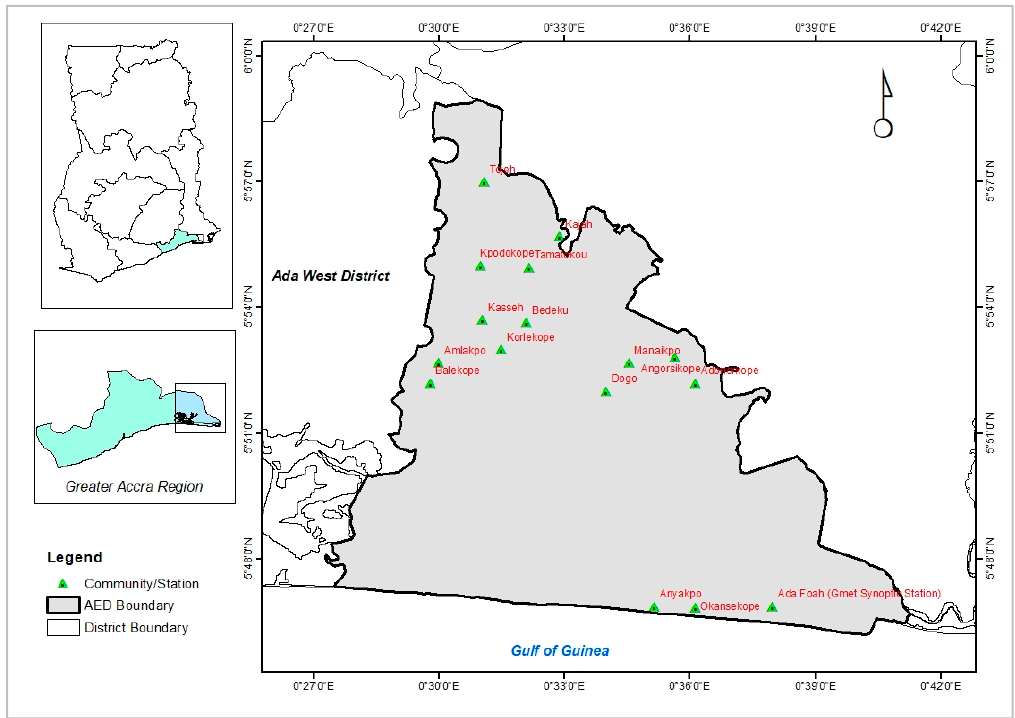
Figure 1. Map of the study area in the Greater Accra Region, Ghana, showing the various communities of Ada East District [29].